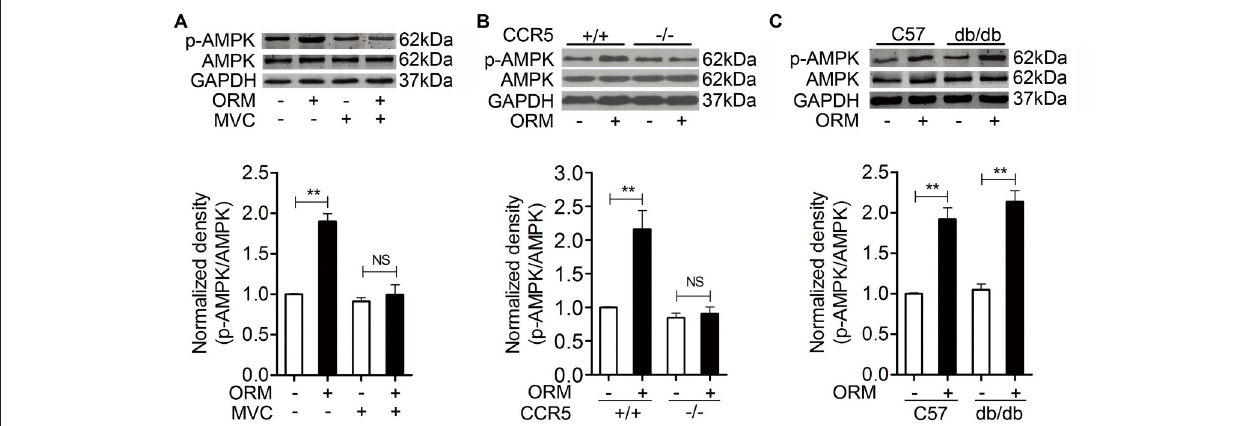
FIGURE 3 | ORM-induced AMPK activation is dependent of CCR5 in skeletal muscles. (A) Representative western blotting of p-AMPK and total AMPK and quantification of the result in soleus muscle tissues of mice 30min after tail-vein injection with vehicle, 200mg/kg ORM, 200mg/kg ORM in absence or presence of 200mg/kg Maraviroc (MVC, gastric gavage for consecutive 3 days). n = 6 per group. (B) Representative western blotting of p-AMPK and total AMPK and quantification of the result in soleus muscle tissues of CCR5 + / + or CCR5 − / − mice 30min after tail-injection with vehicle or 200mg/kg ORM. n = 6 per group. (C) Representative western blotting of p-AMPK and total AMPK and quantification of the result in soleus muscle tissues of C57BL/6 or db/db mice 30min after tail-injection with vehicle or 200 ˙ mg/kg ORM. n = 6 per group. All data are expressed as the mean ± s.d. NS, non-significant, ** P < 0.01 by two-way ANOVA with Turkey’s post-hoc test.